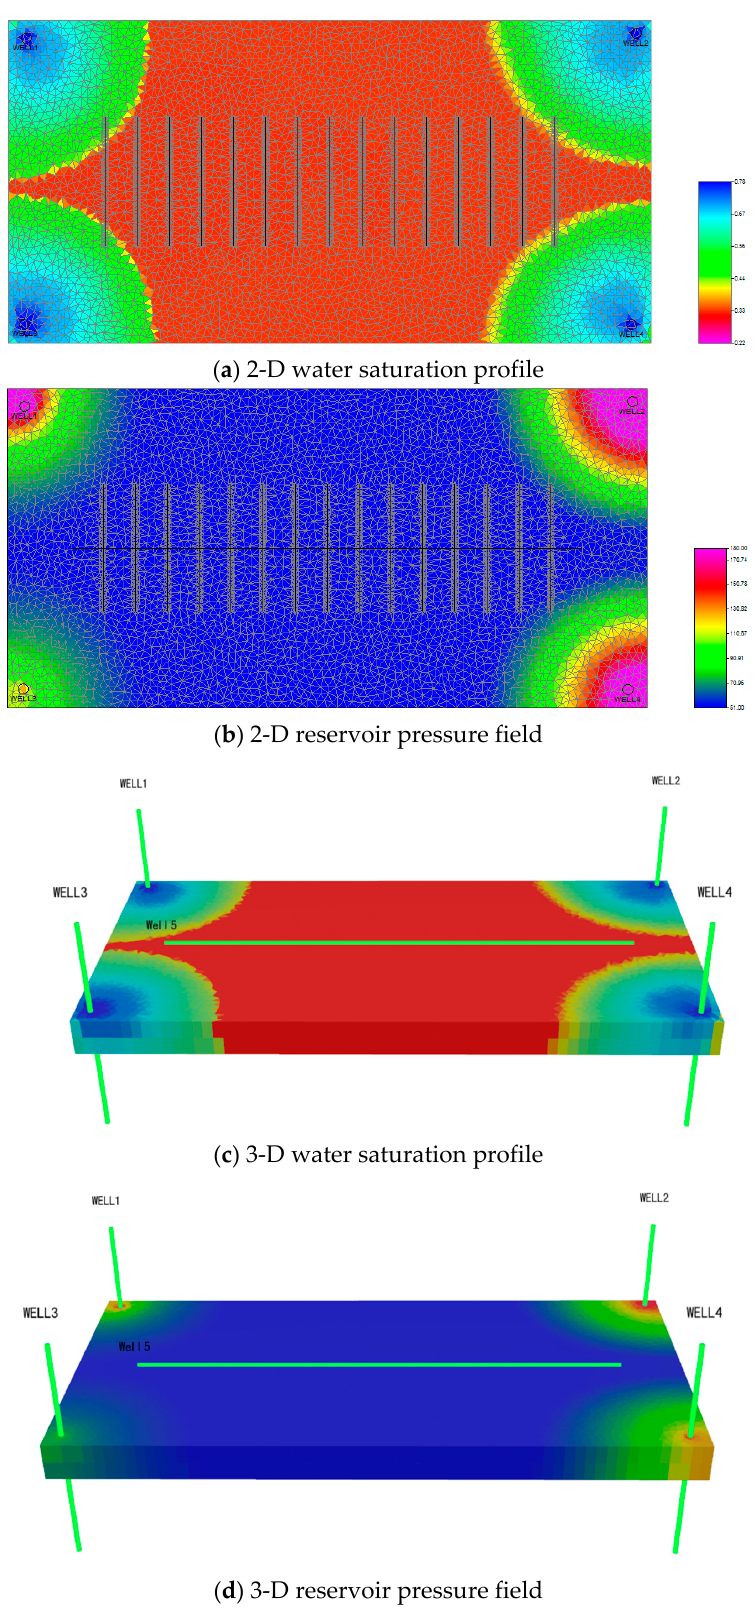
Figure 19. Water saturation and reservoir pressure profile at 0.085PV water injected.